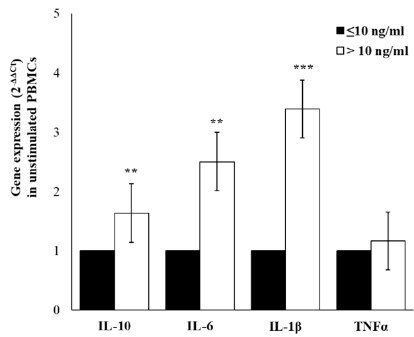
Figure 3. Cytokines gene expression. Basal IL-10, IL-6, IL-1 β , and TNF α expression levels in PBMCs from enrolled workers with salivary cortisol levels ≤ or > of 10 ng / mL. Data are reported as mean. 2 − ∆∆ Ct ± SE. ** p -value ≤ 0.01; *** p -value ≤